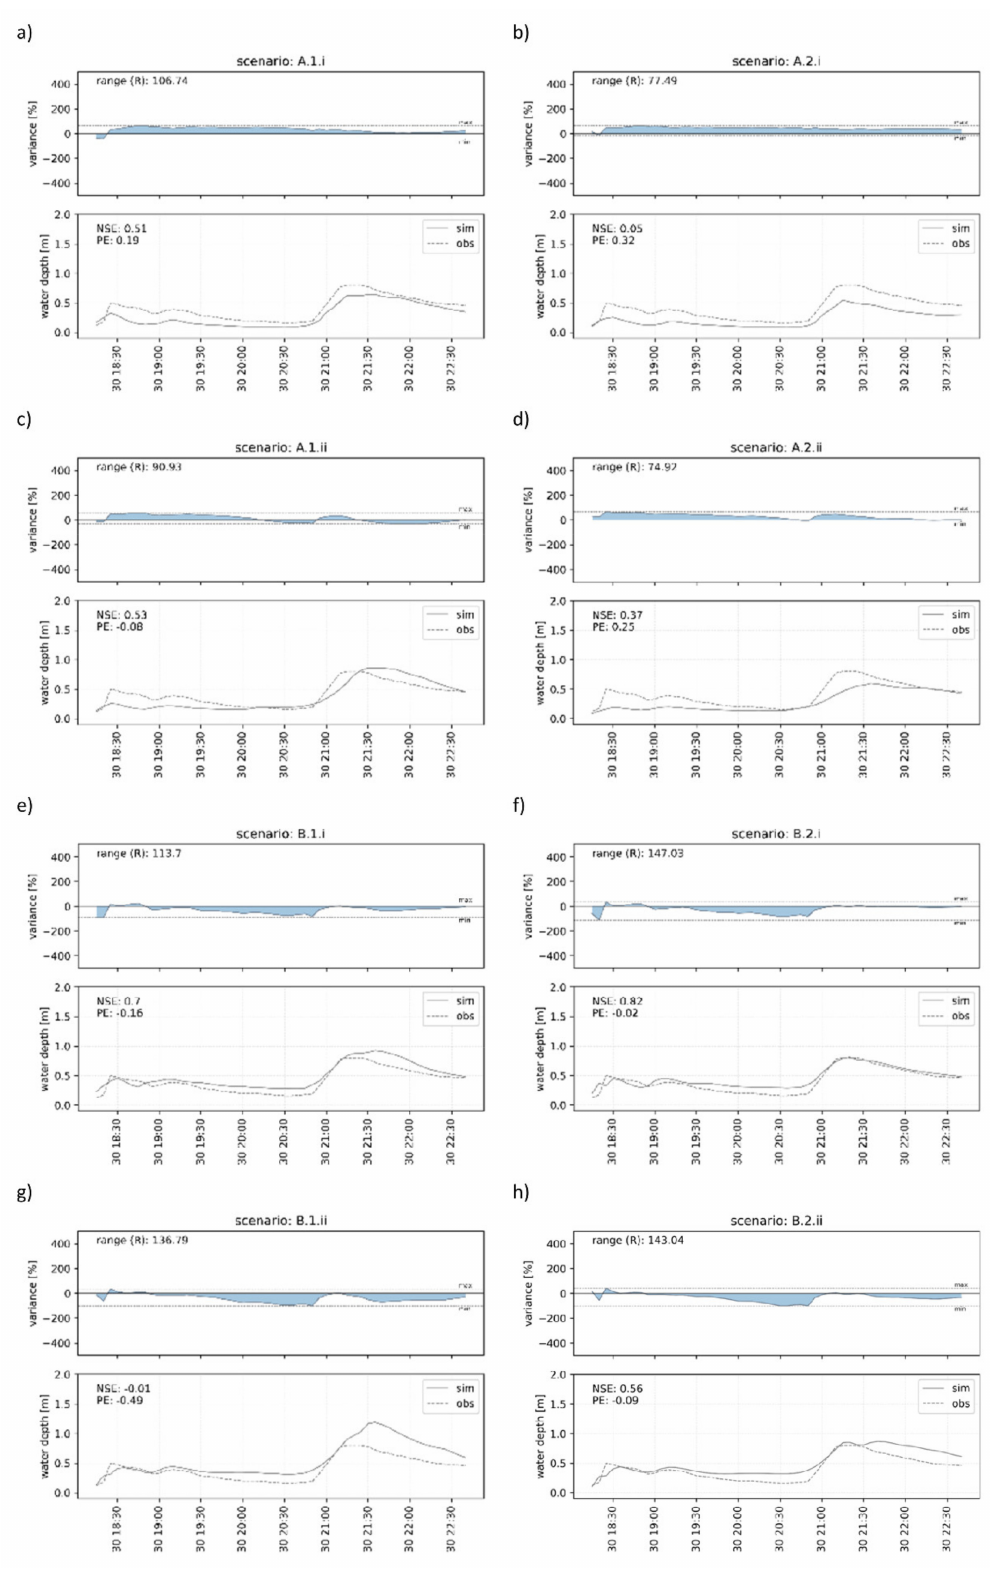
Figure 9. Range of relative deviation (R s ) for the model variable water depth to estimate UC k of each scenario ( a – h ) for the identification of the most impact uncertainty source and NSE and the PE to evaluate the model performance of each